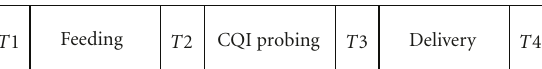
Figure 2: Detailed time-span of the IMDR scheme.